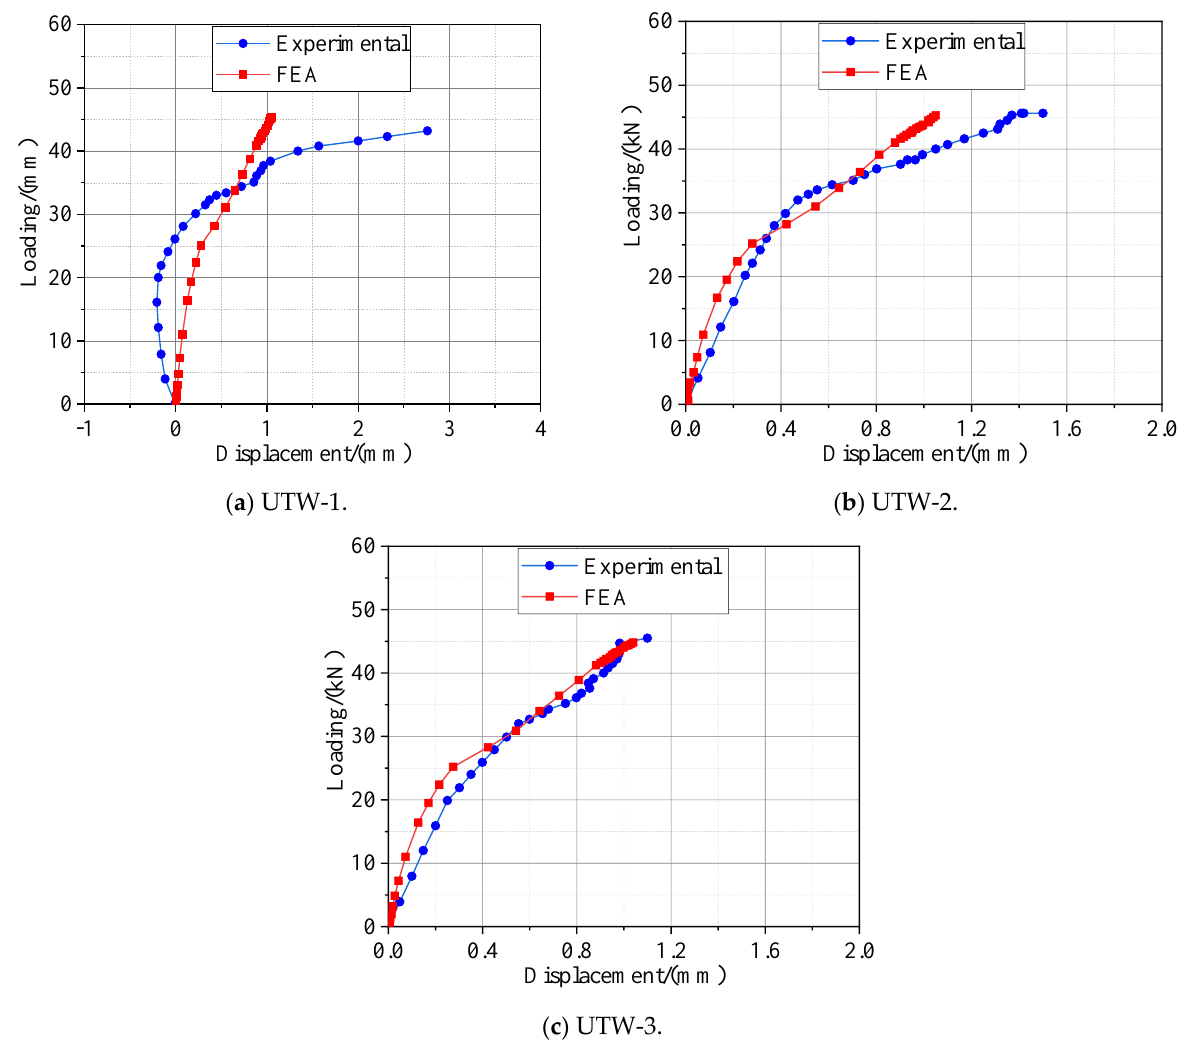
Figure 23. Comparison of loading−displacement curves.